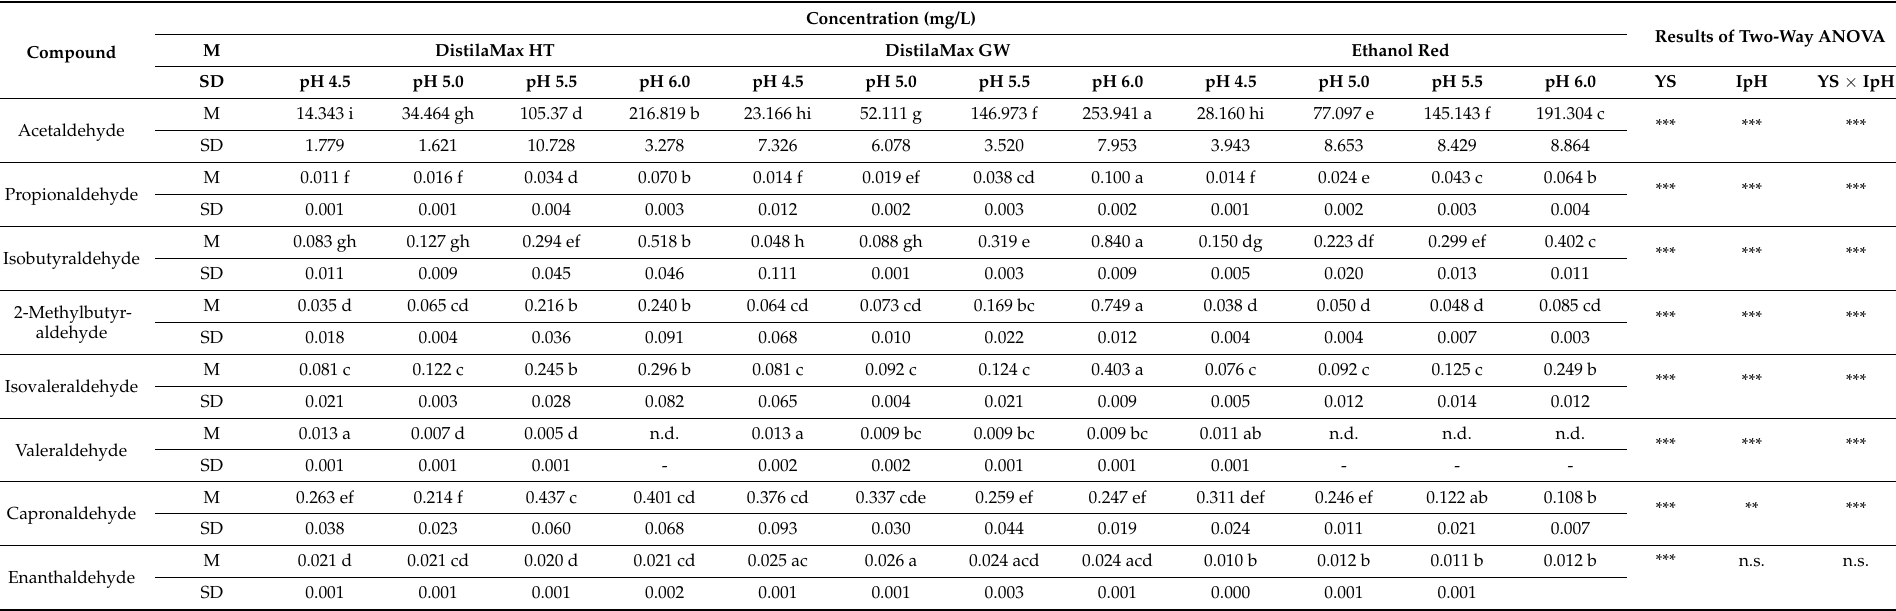
Table 6. Concentrations of aldehydes in the fermented mashes prepared using the pressure-thermal method.